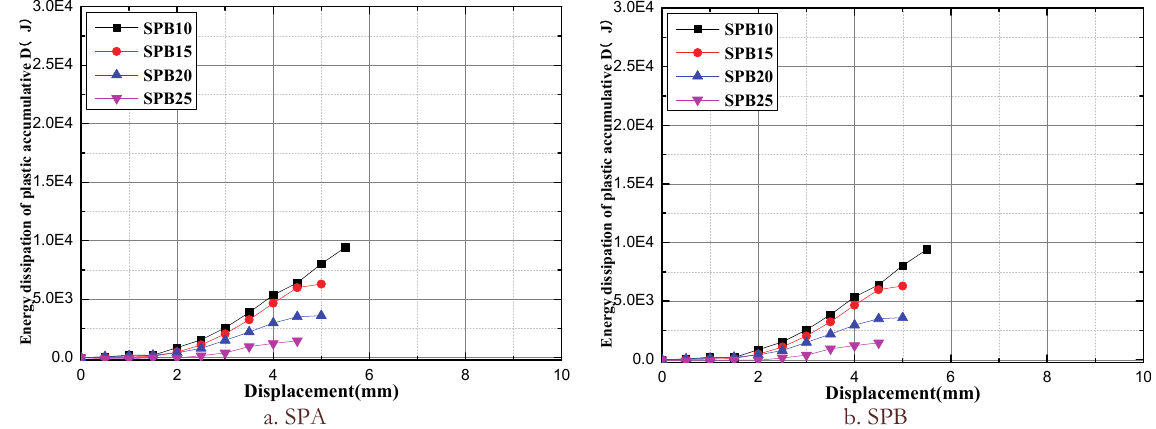
Figure 12: Plastic dissipation energy of SPA and SPB during the cyclic loading